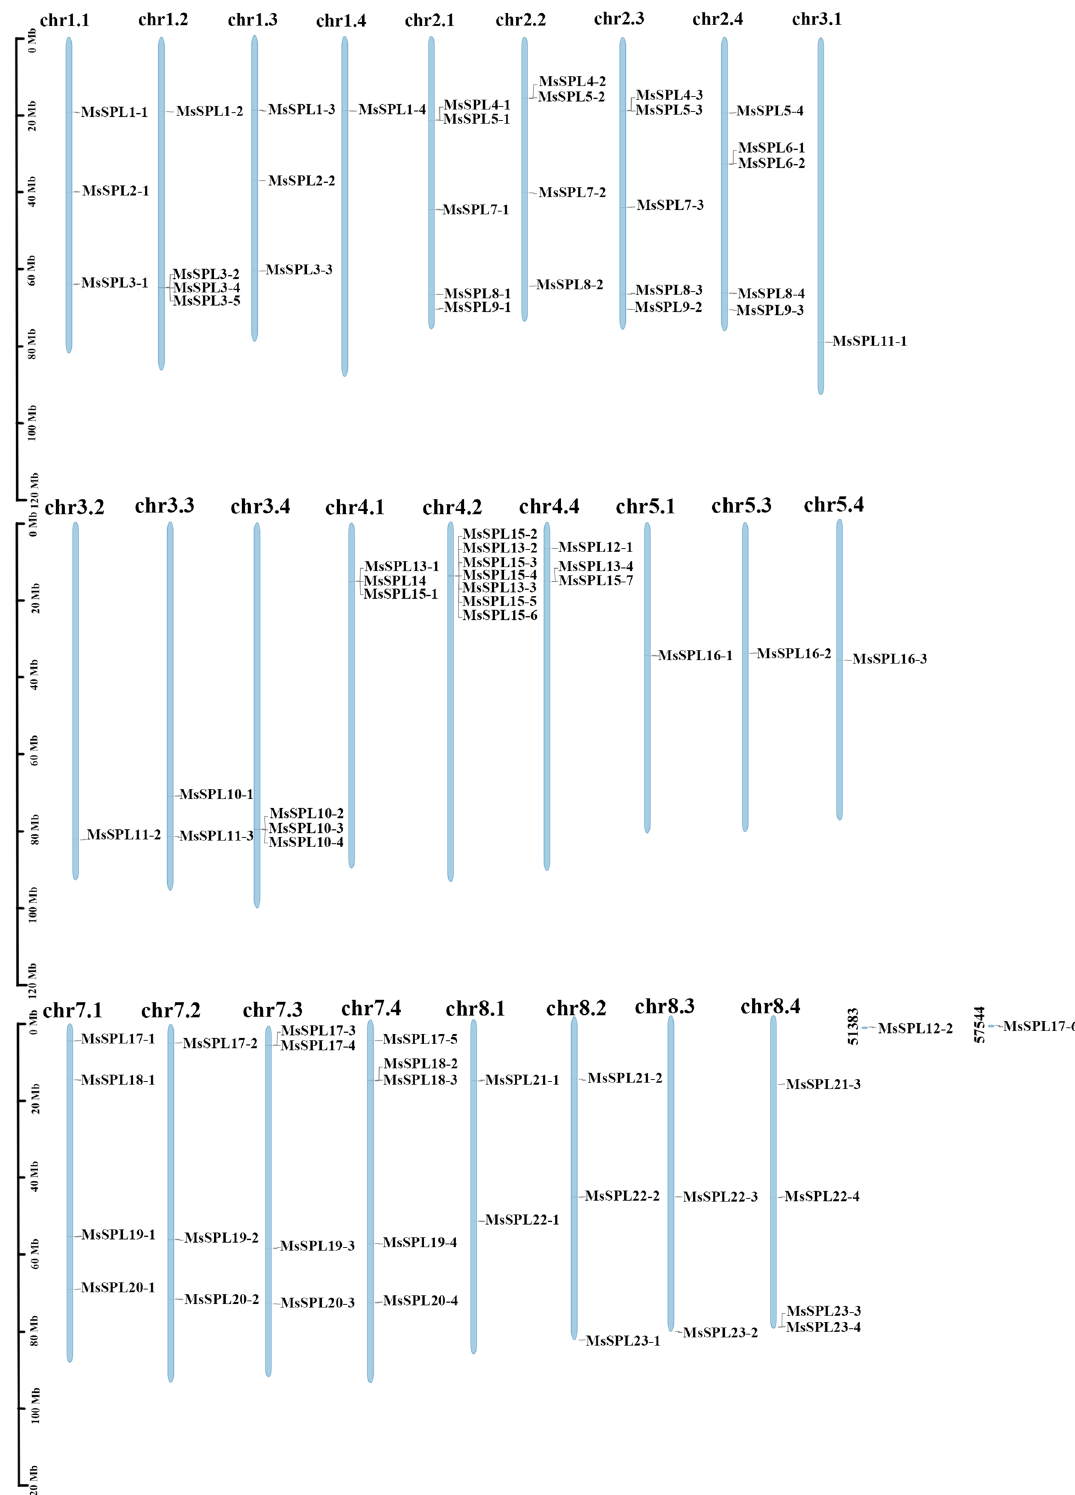
Figure 1. Chromosomal location of the MsSPLs . Distribution of the SPL gene in the alfalfa genome. The MsSPLs are located on chromosomes 1.1-1.4, 2.1-2.4, 3.1-3.4, 4.1-4.2, 4.4, 5.1, 5.3-5.4, 7.1-7.4, and 8.1-8.4. The number of the chromosome is shown at the top of the chromosome. The scale (Mb) represents the length of the